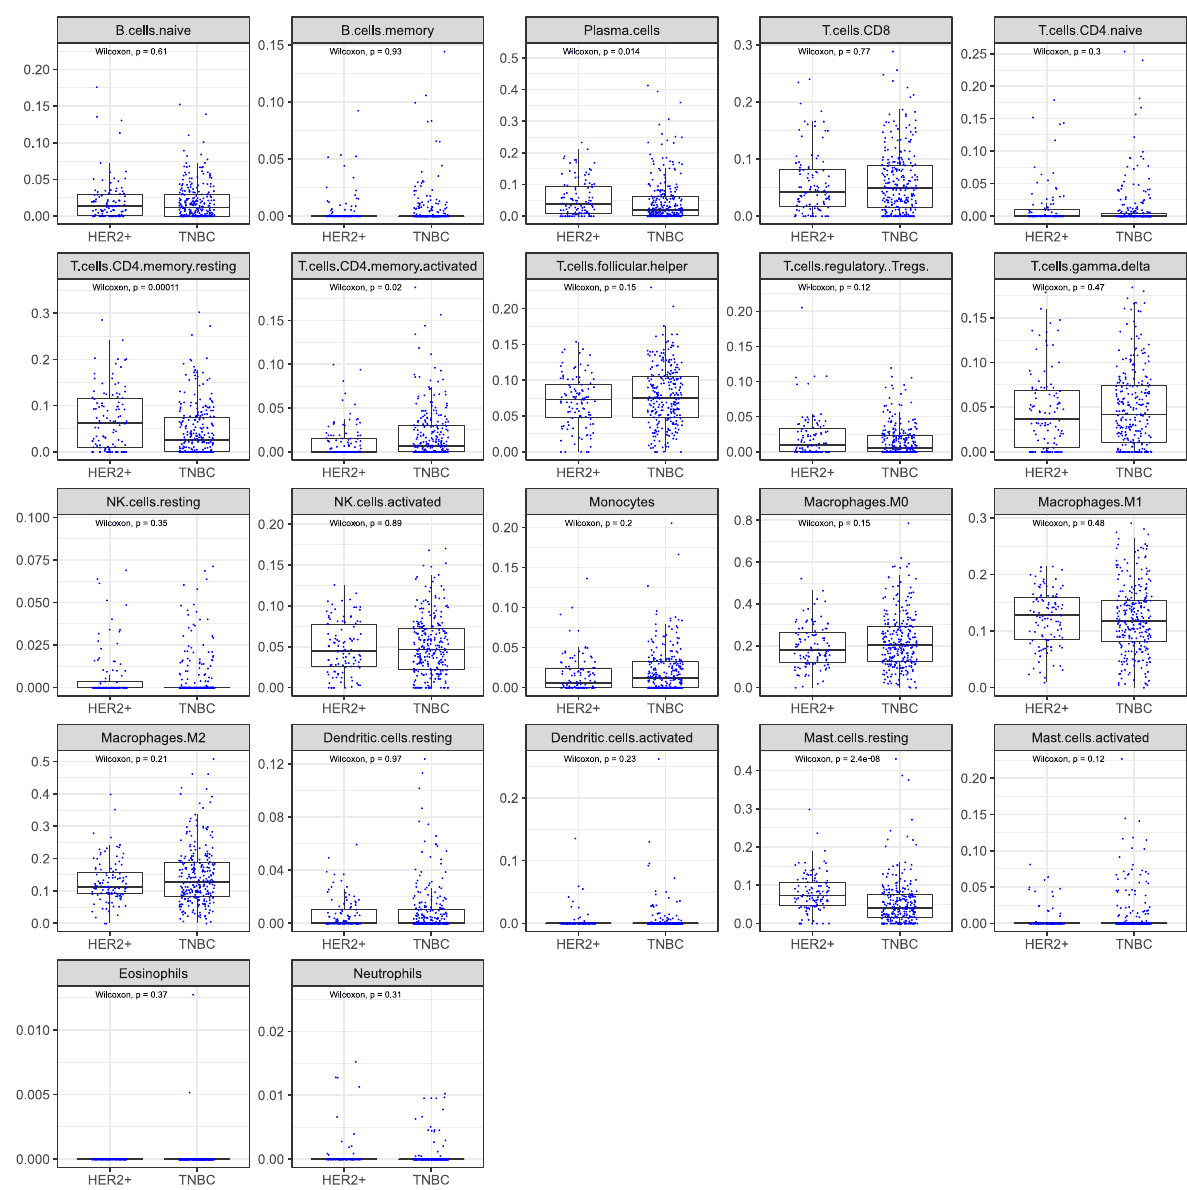
Fig. 2 CIBERSORT deconvolution for 265 TNBC, and 109 HER2 + /ER-/PR- patients. Wilcoxon test p -values are indicated for each cell